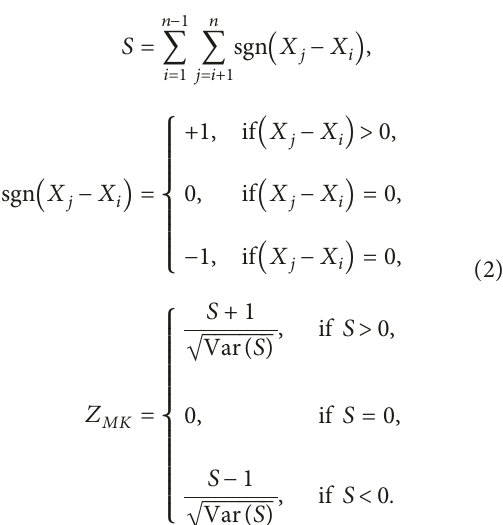
Figure 1: Minjiang River drainage